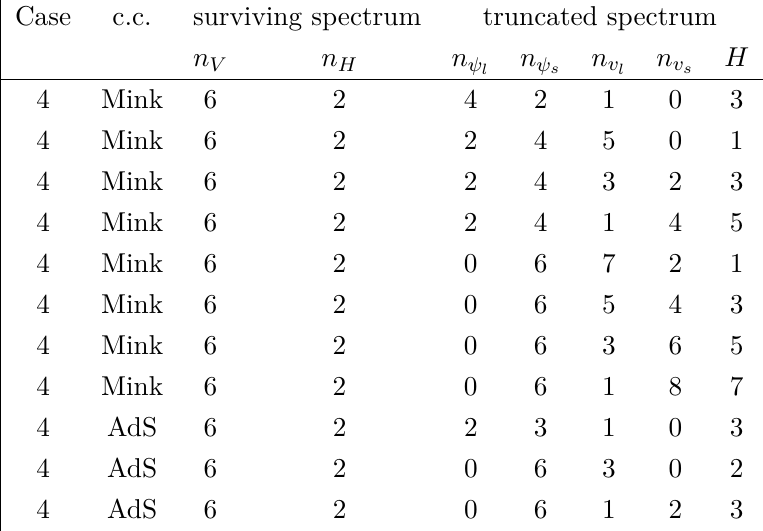
Table 4 . Supersymmetry breaking patterns and truncation of the spectrum — case 4.